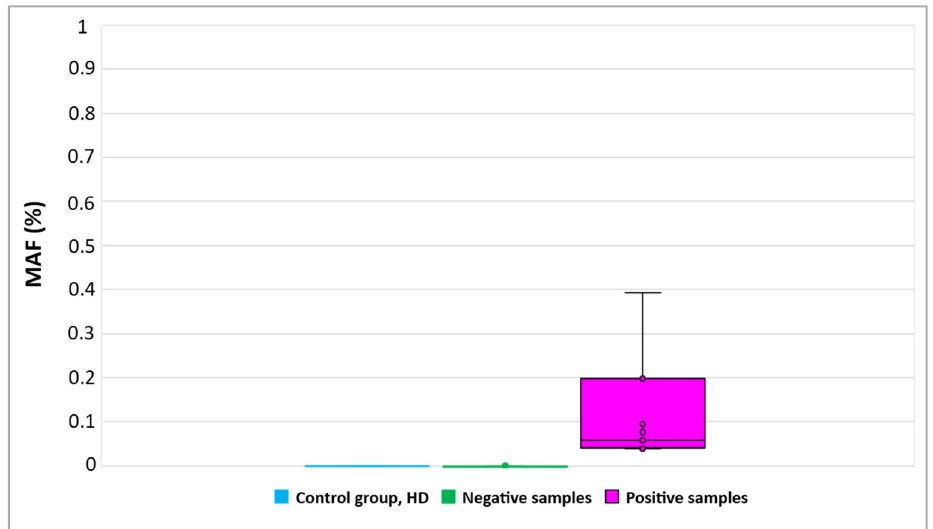
Figure 3. Detection of ESR1 mutations in plasma-cfDNA samples using drop-off ddPCR. (MAF: mutant allele frequency).